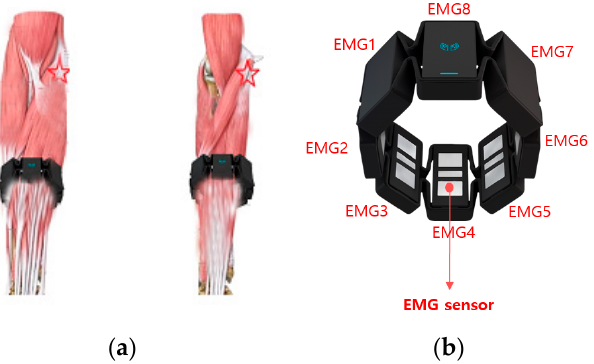
Figure 1. ( a ) Positioning of a Myo device for electromyogram (EMG) measurement, ( b ) eight EMG signals of one Myo device.